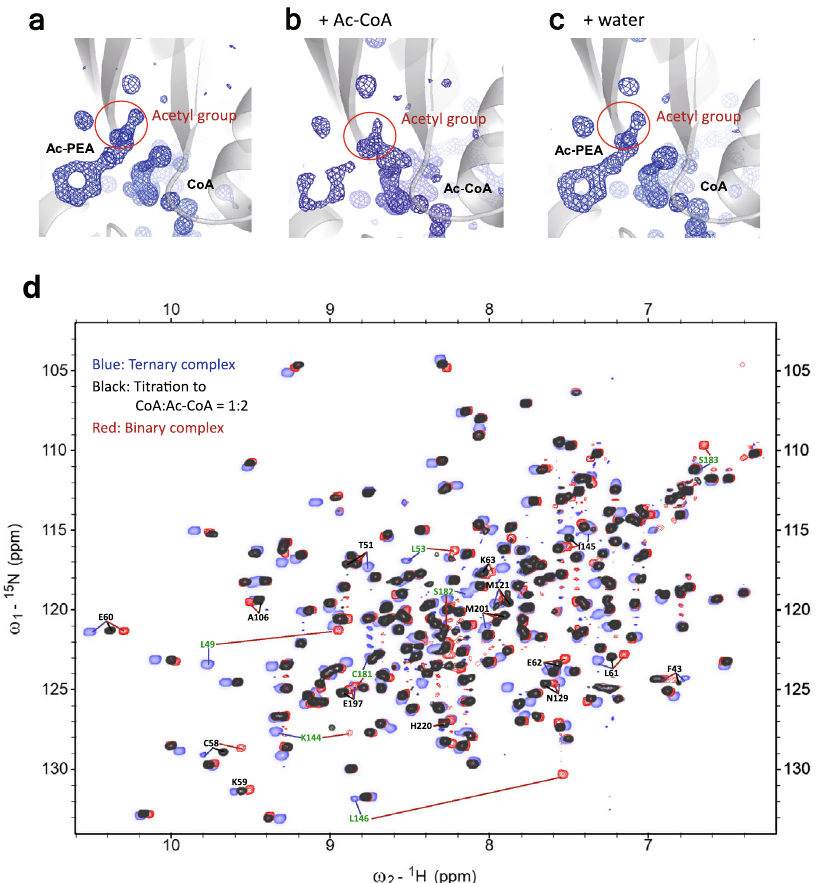
Fig. 6 Acetyl-CoA can eliminate the products of Dat and form a new binary complex. a – c Fo – Fc omit electron density maps contoured at 3 σ for ligands in the crystal of the Dat/CoA/Ac-PEA complex ( a ), the crystal after mixing the Dat/CoA/Ac-PEA crystal with Ac-CoA solution ( fi nal concentration of 20 mM) for 30 min ( b ), and the crystal after mixing the Dat/CoA/Ac-PEA crystal with pure water for 30 min ( c ). d Superimposition of HSQC spectra of the Dat/CoA/Ac-PEA complex (blue), end of Ac-CoA titration (CoA:Ac-CoA = 1:2, black), and Dat/Ac-CoA complex (red). Residues that lost the resonances corresponding to the end of titration are labeled in green. Some residues that showed signi fi cant CSP between the end of titration and the binary complex are labeled in